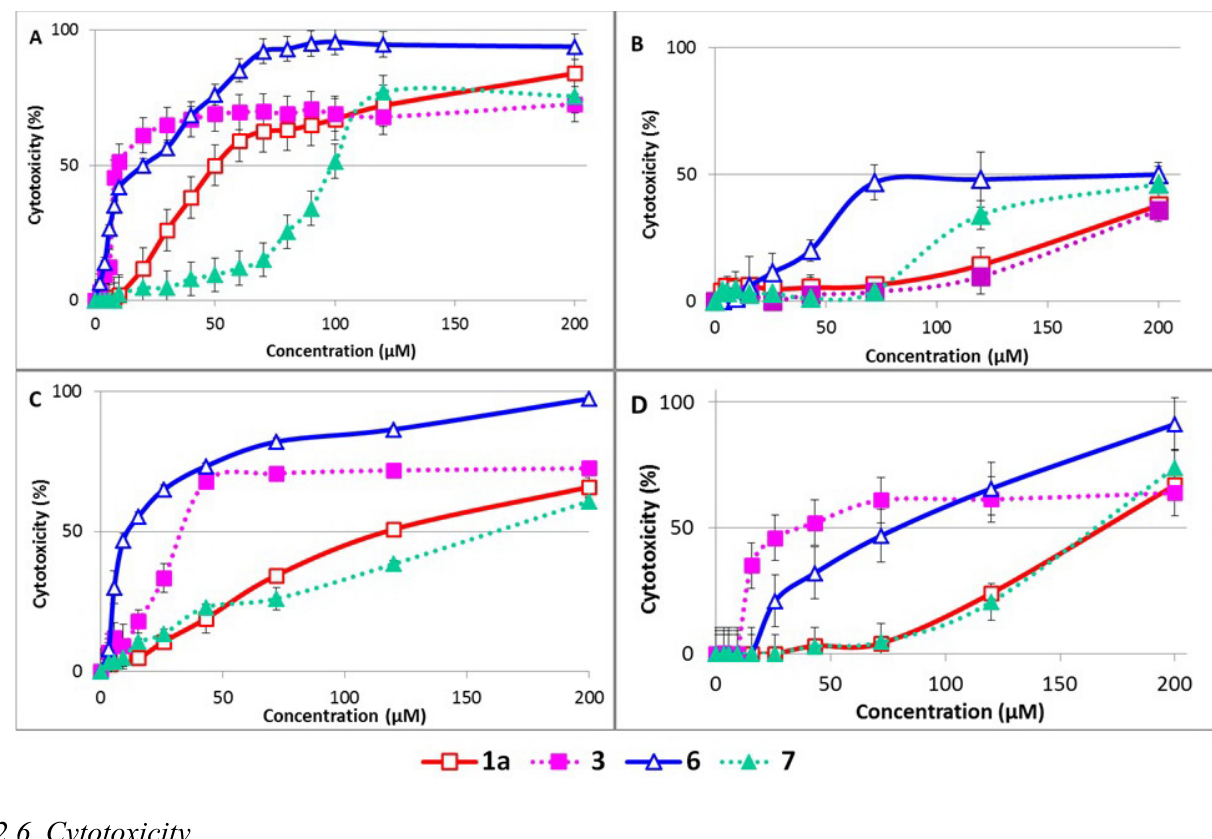
Figure 4. Effect of studied compounds on ( A ) human umbilical vein endothelial cells; ( B ) human normal adult keratinocytes; ( C ) mouse BALB/c fibroblasts and ( D ) HepG2 cells. The cells, grown to near confluence, were incubated with the tested compounds for 24 h and their viability was then assessed by MTT test. The results are presented as mean ± SD from three independent experiments performed in